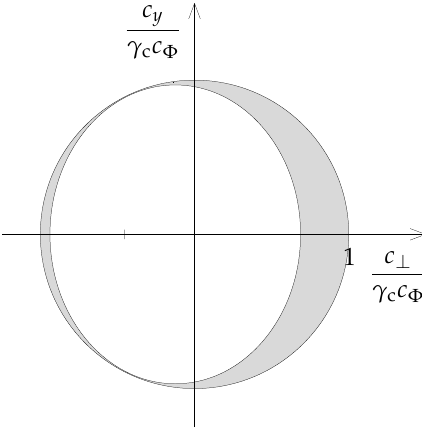
(cid:0) c ⊥ (cid:1) Figure 2. The points , c y of the disk of radius one that yield quantum no-scale regimes (QNSRs) γ c c Φ γ c c Φ a → ∞ and a → 0 sit in the left and right shaded crescents,